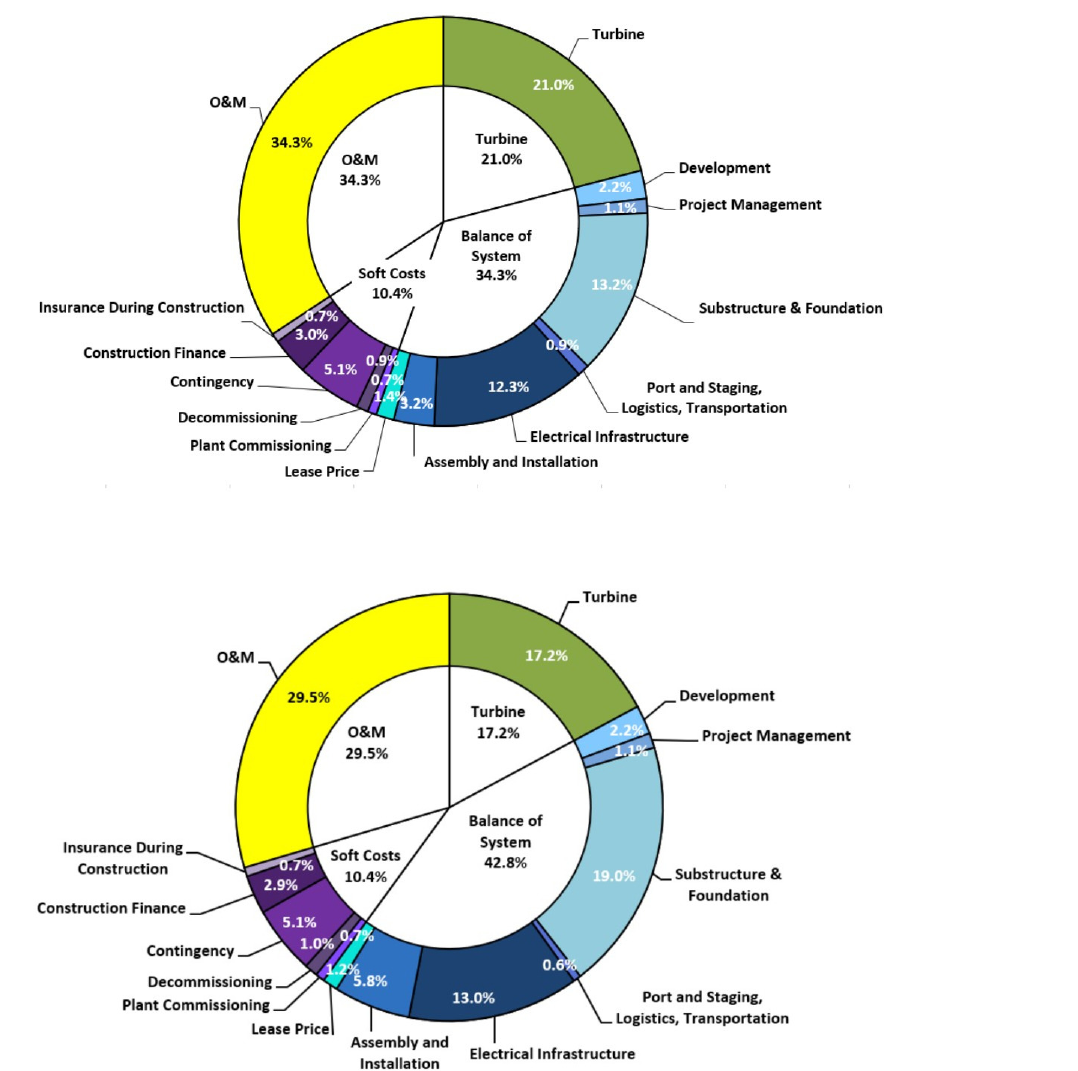
Figure 9. Comparison of component-level LCOE contribution for fixed-bottom (top panel) vs. floating wind (bottom panel) farms operating for 25 years (Stehly et al.,